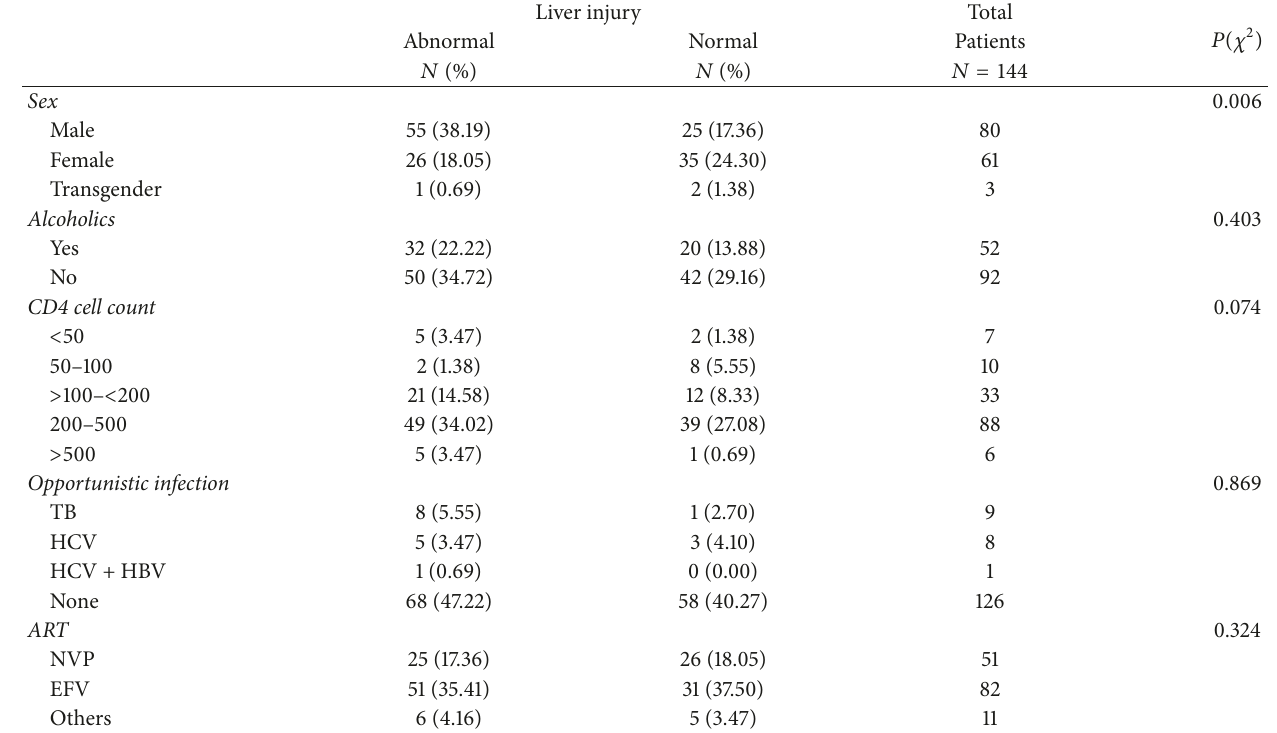
Table 3: Patients characteristics and frequency of liver injury.